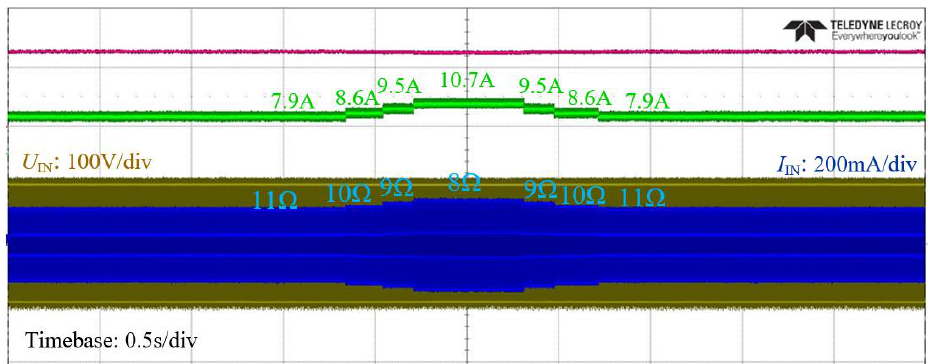
Figure 19. Experimental dynamic response waveforms of multi-load regulation in the CV mode.